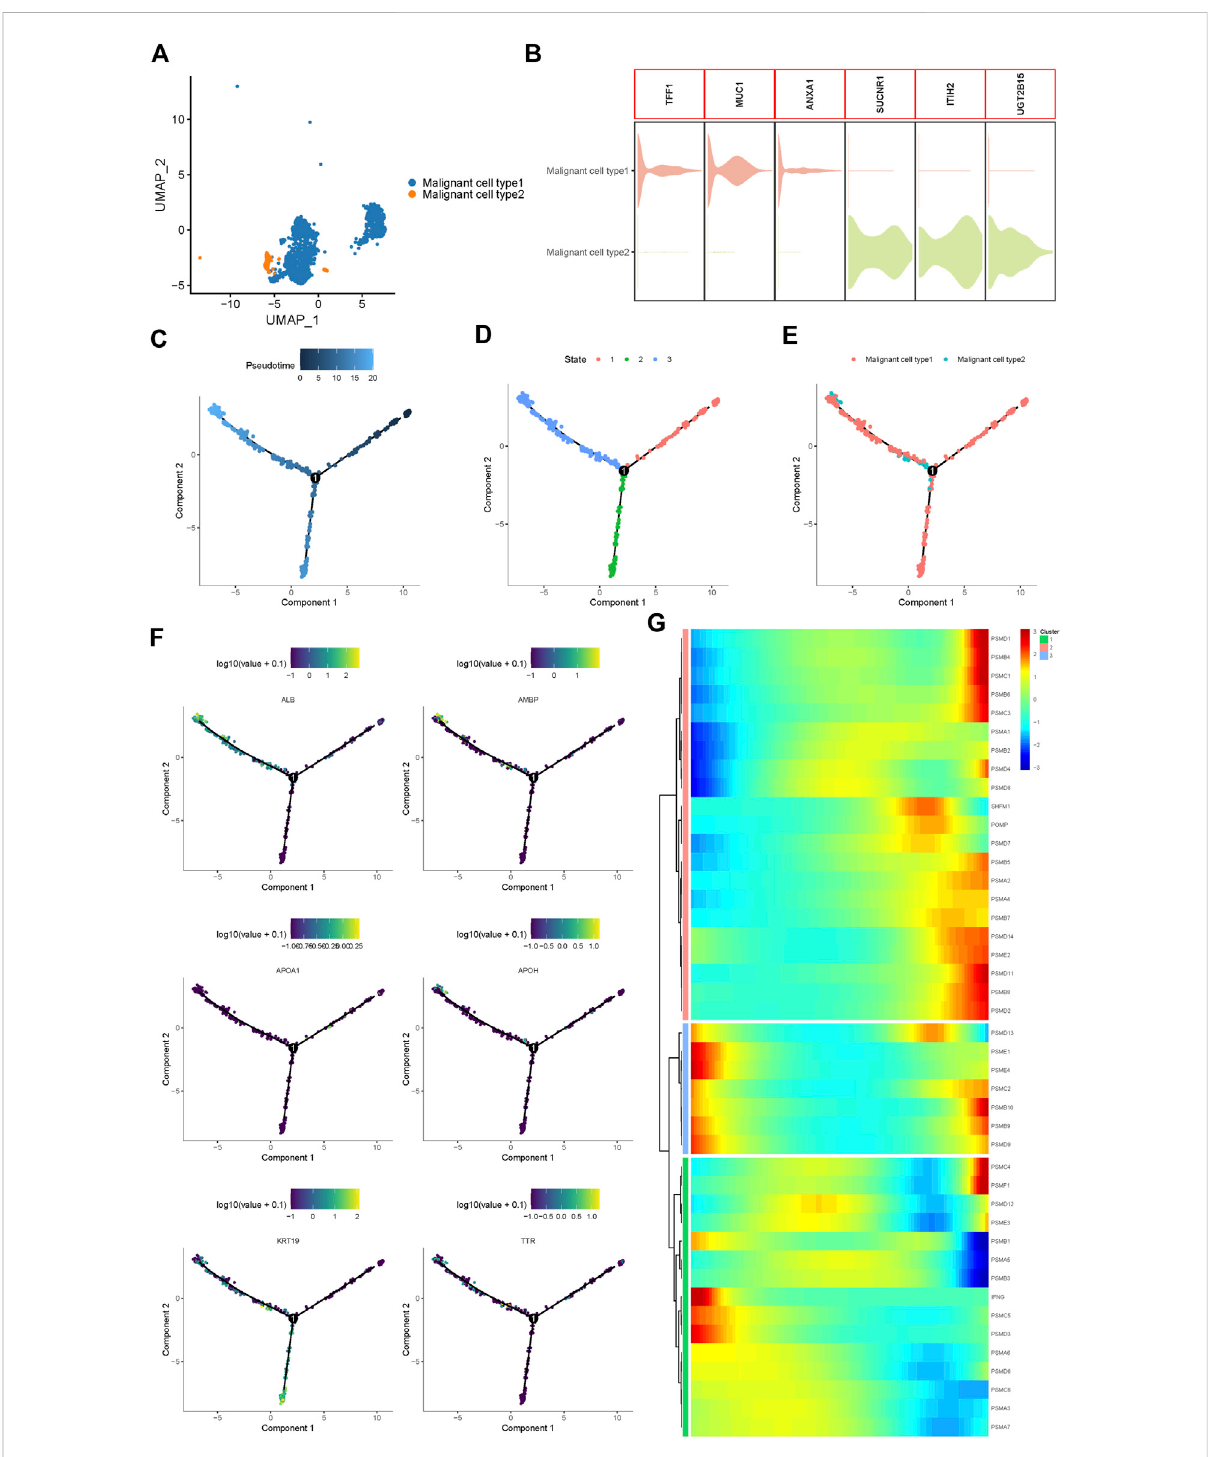
FIGURE 2 Proteasome-related genes are signi fi cantly out of balance during the progression of iCCA cells. (A) Two main malignant iCCA cell types were identi fi ed by UMAP analysis. (B) The violin plots showing the representative markers of the two malignant cell types. (C – E) Simulation of the differentiationtrajectoryofmalignantiCCAcelltypes. (F) Thedistributionofrepresentativegenesinpseudo-trajectoryofmalignantcellsofiCCA. (G) Heatmap hierarchical clustering showing differentially expressed proteasome-related genes along with the pseudo-time